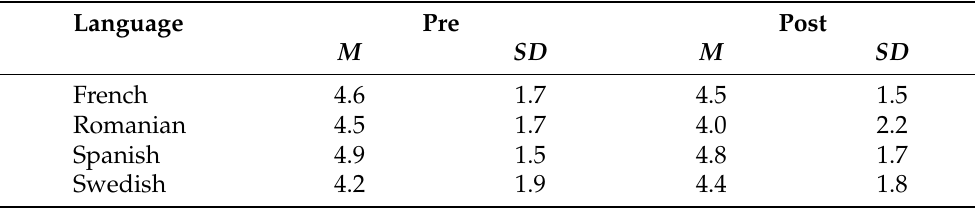
Table A10. I check what people say about the story online (e.g., on blogs, social media, opinion makers’ websites).